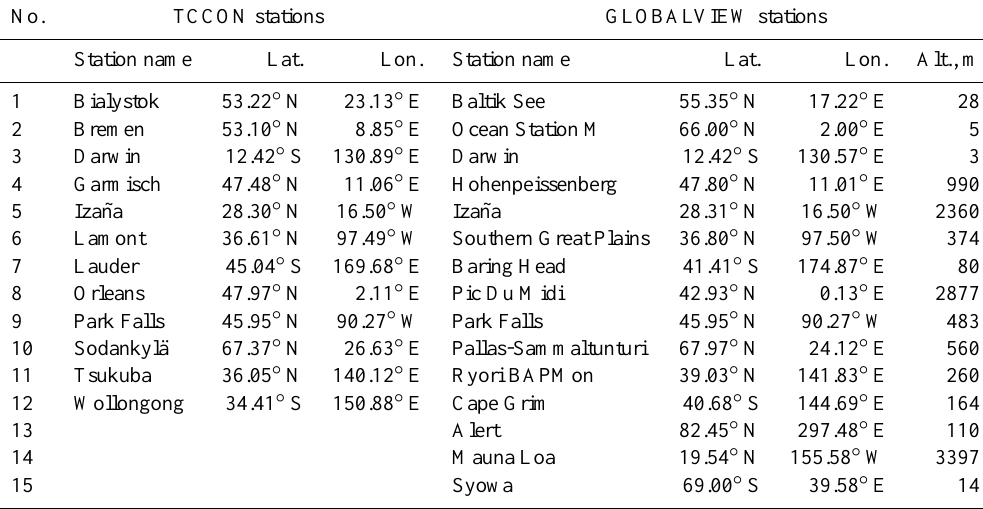
Table 2. Locations of TCCON and GLOBALVIEW stations used in the comparisons.